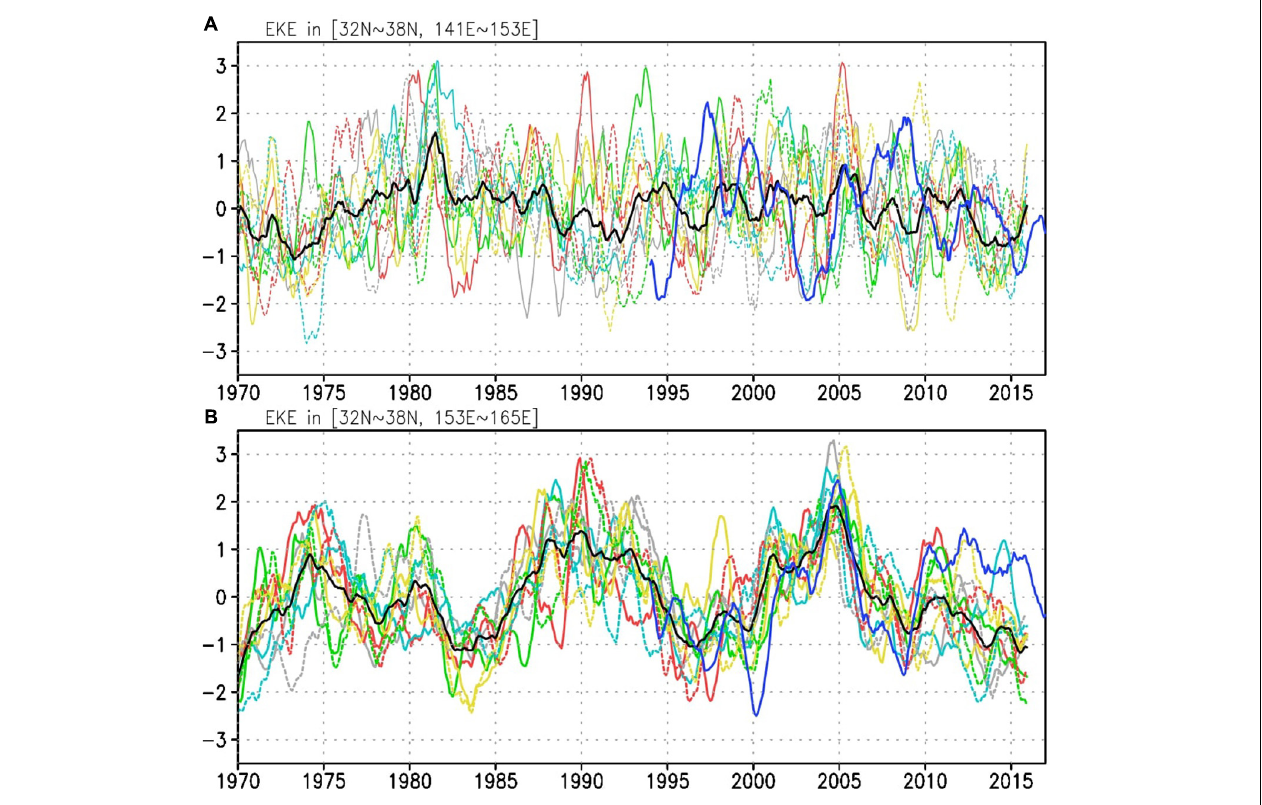
FIGURE 6 | Time series of the standardized area-mean EKE anomalies in panel (A) the KE upstream region [32 ◦ –38 ◦ N, 141 ◦ –153 ◦ E] and (B) the KE downstream [32 ◦ –38 ◦ N, 153 ◦ –165 ◦ E] for each ensemble member (thin curves), the ensemble mean (thick black curve), and the observation (thick blue curve). The time series of observation and each ensemble member are standardized by dividing the original time series by their standard deviations. The ensemble mean is divided by the mean of standard deviations of all ensemble members.